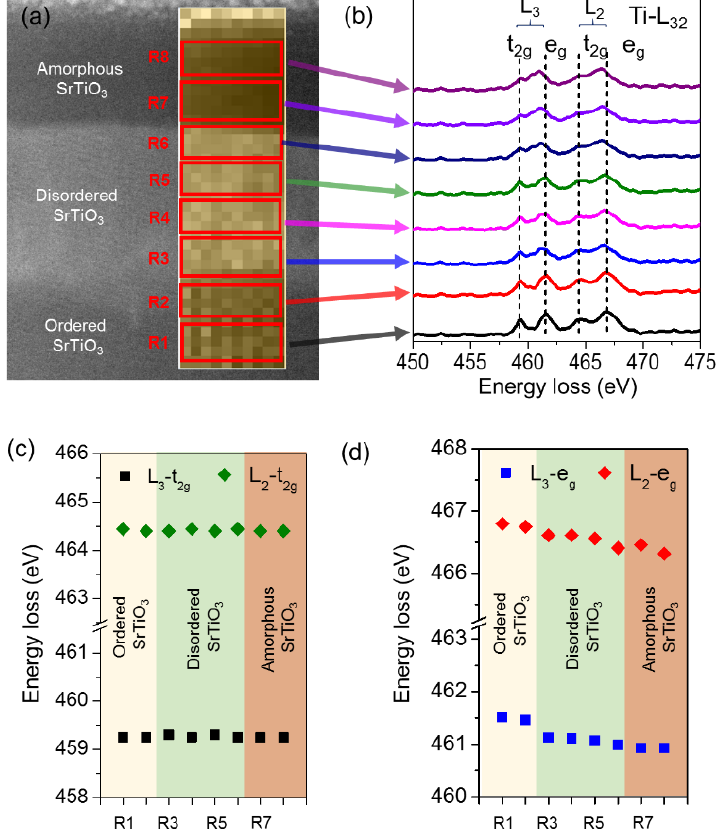
Figure 5. ( a ) Depicts an ADF image overlaid with a pixelated ADF image (inset reveals R1 to R8 regions for the collection of EELS spectra), ( b ) shows Ti–L 2, 3 edge character from the region R1 to R8. ( c ) Plots showing the energy position of fitted peaks for Ti– t 2g peaks corresponding to regions R1 to R8. Similarly, ( d ) illustrates the energy position of fitted peaks for Ti– e g peaks corresponding to regions R1 to R8, within the fitting deviation limits.